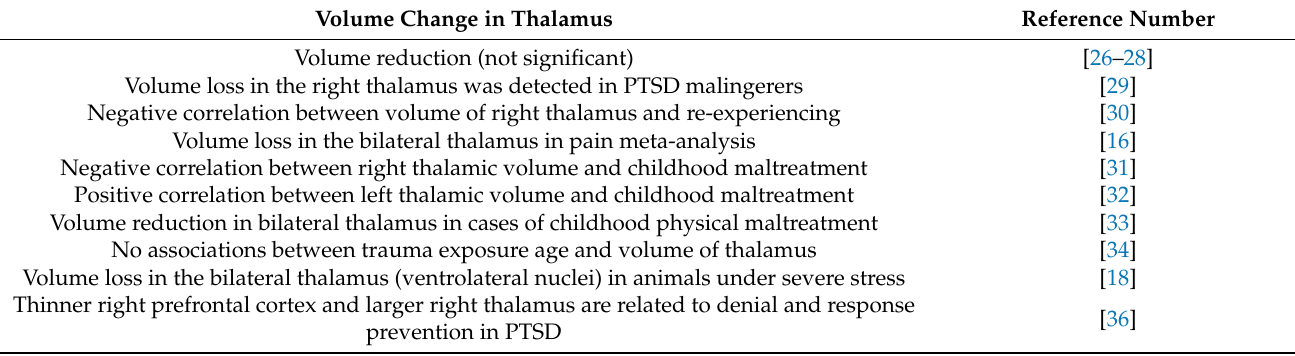
Table 1. The summary of literature study for structure and regional activity in the